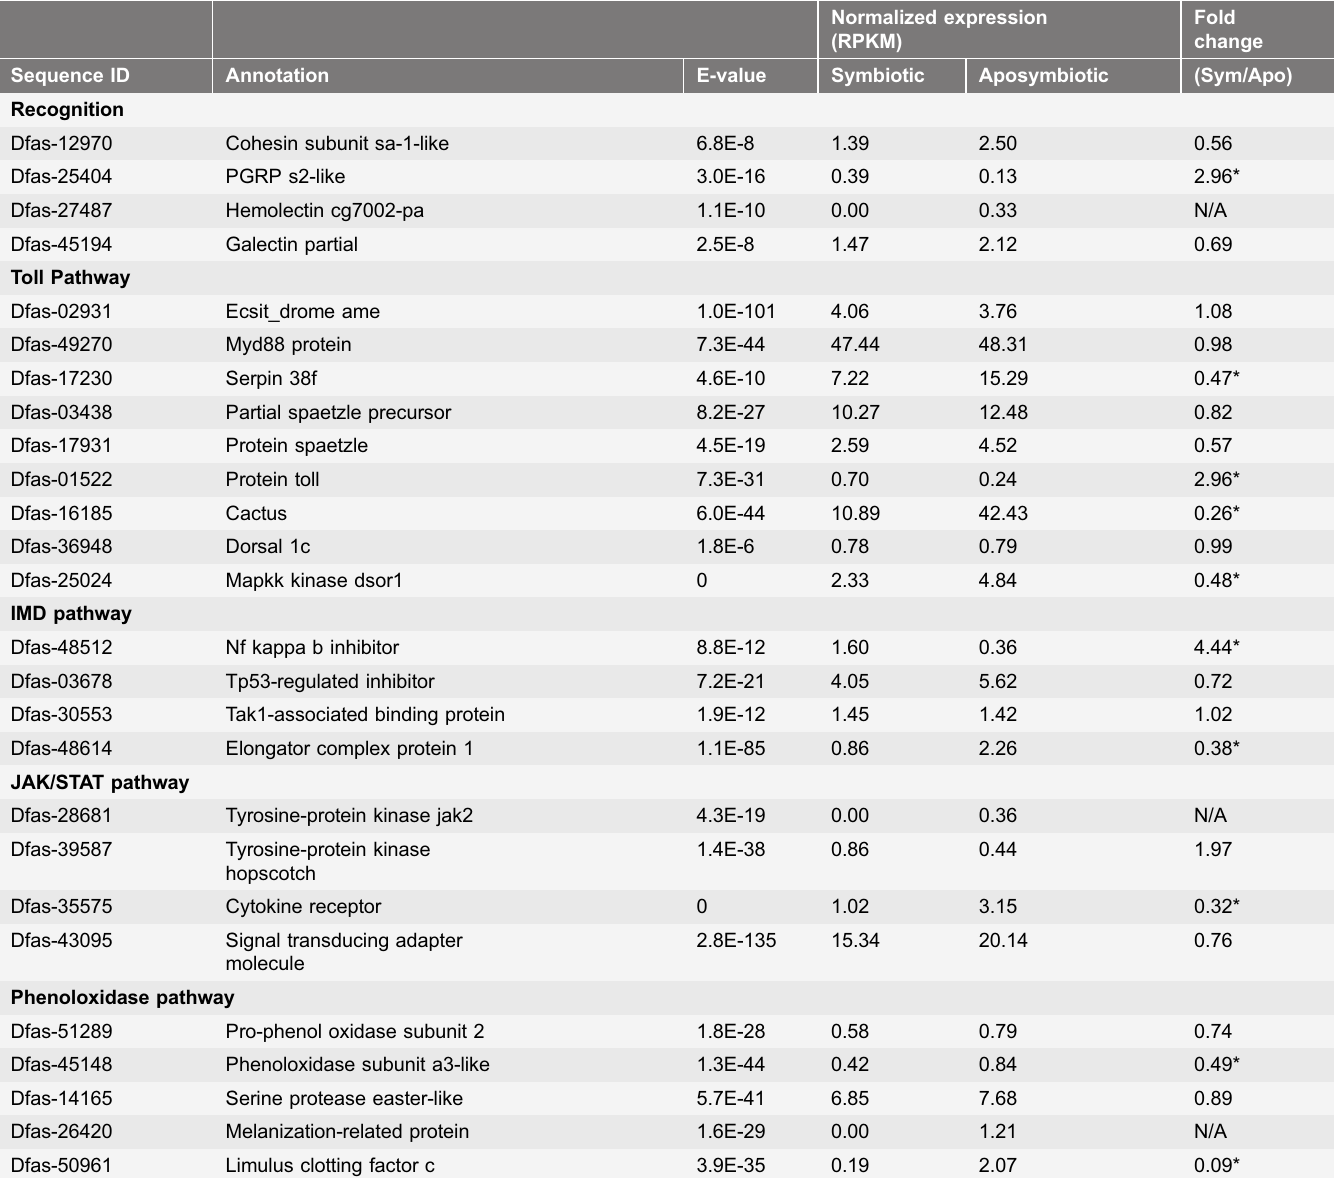
Table 1. Annotation and normalized expression values (RPKM) of transcripts putatively involved in recognition and signalling of the innate immune response.